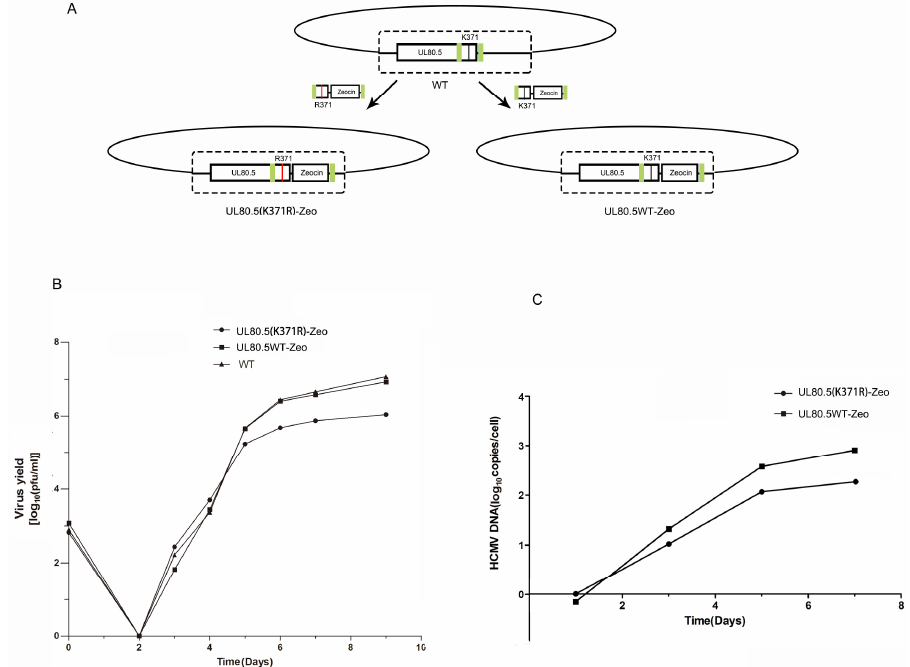
Figure 6. Mutation of 371 lysine attenuates HCMV replication in HFFs. ( A ) Schematic for BAC construction and generation of wild type, mutant, and control HCMV virus. ( B ) The replication and spread abilities of HCMV were determined by multi-step virus growth curves. HFF cells were in- fected with an appropriate virus (WT, UL80.5(K371R)-Zeo, and UL80.5WT-Zeo) at a MOI of 0.02 and collected at the indicated time points. The released virus at each time point was titrated on HFFs by serial dilutions and plaques counting to generate growth curves. Data are representative of three independent experiments. ( C ) HFF cells were infected with an appropriate virus (UL80.5(K371R)- Zeo, and UL80.5WT-Zeo) at a MOI of 0.01. Viral DNA synthesis was determined by quantitative real-time PCR at each of the time points indicated. The amount of viral DNA assayed is represented as copies of the viral gene UL83 per copy of the cellular β-action gene. 4. Discussion UL80.5 is an essential gene of HCMV and plays a key role in viral capsid assembly [7,37]. To beer understand the biological function of UL80.5, we performed a yeast two- hybrid screen, and the most frequently isolated UL80.5-interacting protein was the SUMO conjugating enzyme UBC9. In this study, we first reported that UL80.5 is a novel target of SUMOylation and could be effectively conjugated with SUMO1, SUMO2, and SUMO3. The conjugation levels of UL80.5 by SUMO1, SUMO2, and SUMO3 proteins were not the same as SUMO1 modification was the strongest. Moreover, several additional higher mo- lecular weight UL80.5 species were detected, suggesting that UL80.5 could be multi- SUMOylated. In mammalian cells, some substrates of SUMOylation were capable of being modified by either SUMO1 or SUMO2/3, and other substrates showed a clear preference for a particular SUMO type [38,39]. Until recently, there were no obvious differences in protein functional types that were modified by SUMO1 versus SUMO2/3. Therefore, we choose SUMO1 modification as a model for our research.